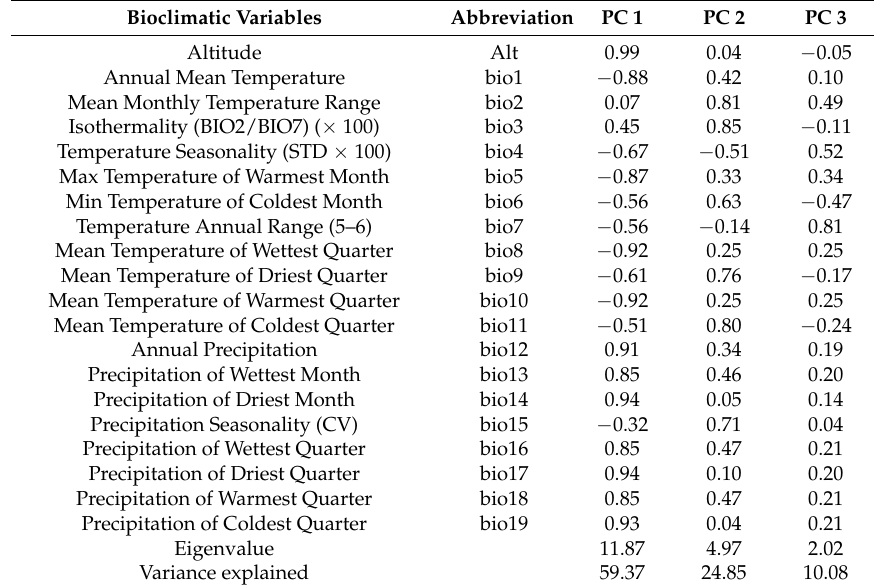
Table 3. Pearson correlation coefficients between climatic variables and the first three principal components, eigenvalues, and variation explained. Absolute values of correlation coefficients greater than 0.057 are statistically significant at the 95% confidence